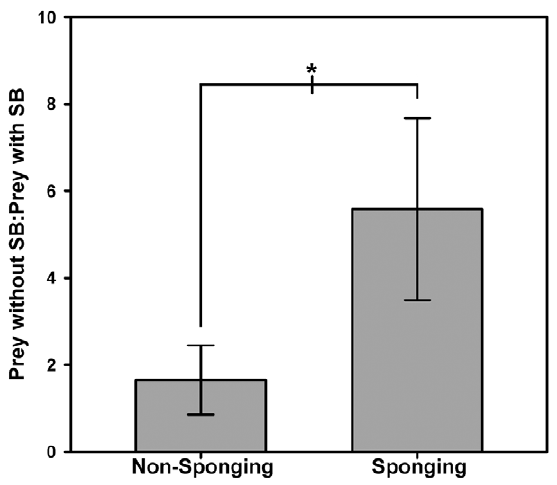
Figure 3. Ratio of prey without swimbladders (SB) to prey with swimbladders during both Sponging and Non-Sponging on transects. Data were transformed ( + 1) before ratios were calculated to correct for undefined ratios in samples with zero individuals in either group. Wilcoxon Sign Rank Test W=28, *P=0.016.